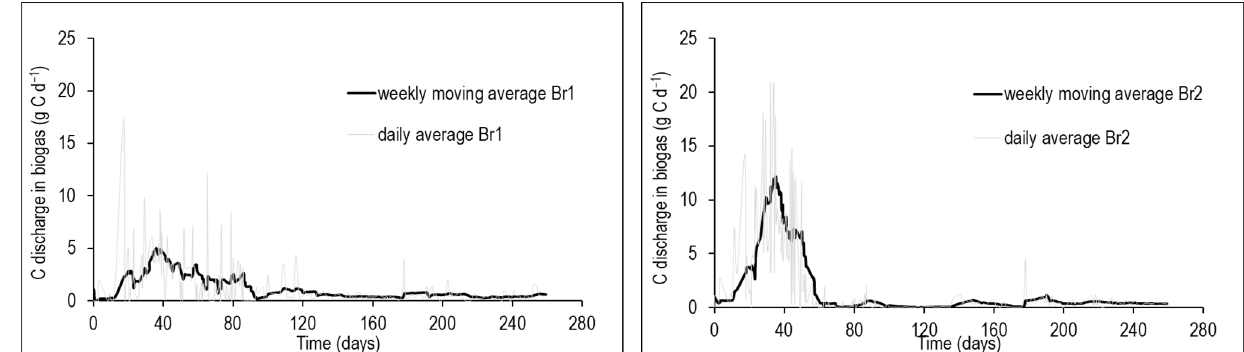
Figure 6. Carbon discharge in the biogas produced in bioreactors.